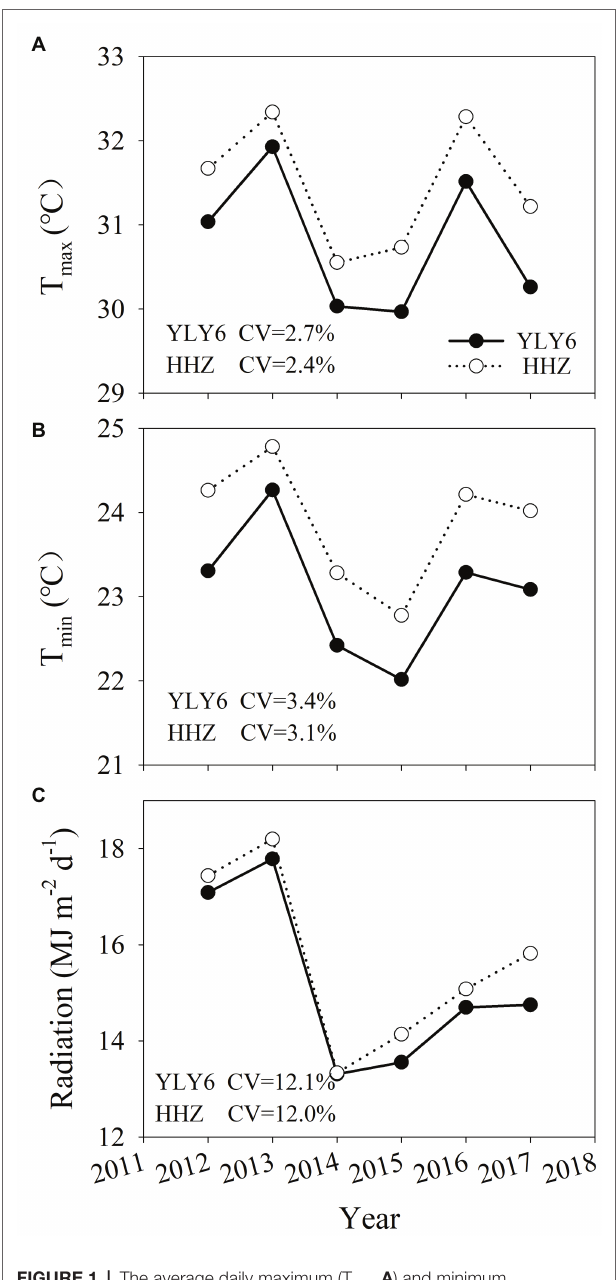
FIGURE 1 | The average daily maximum (T max , A ) and minimum temperature (T min , B ), and solar radiation (C) for YLY6 and HHZ during the rice-growing seasons (from transplanting to maturity) in Hubei Province, China, from 2012 to 2017. CV is the coefficient of